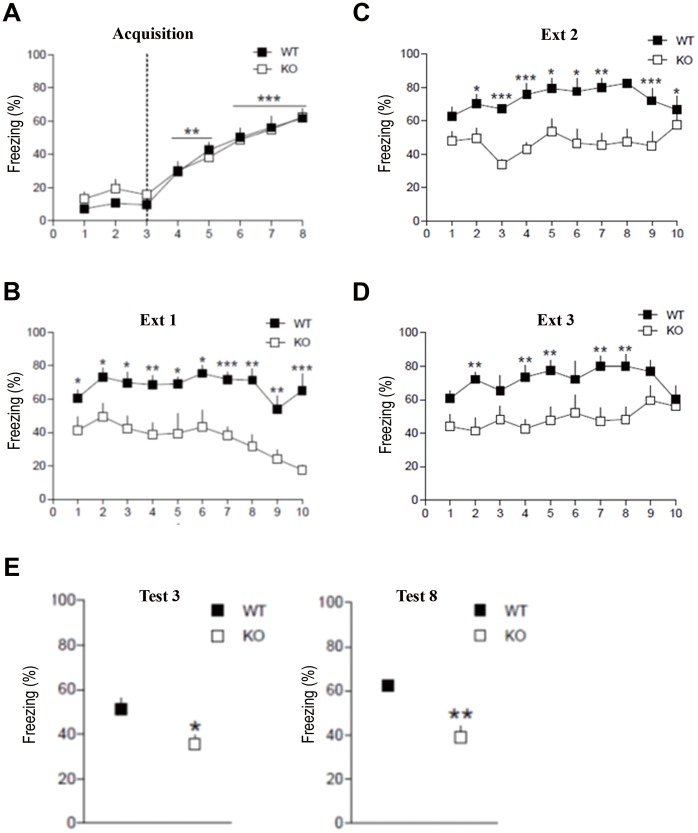
Contextual fear conditioning and extinction in FMR1−/− mice and WT littermates.(A) Acquisition of contextual fear conditioning. Mice were placed in a context for 3 min and received a foot shock every 60 sec for 5 times. Mice significantly increase freezing responses when compared to baseline (BL) measures before US presentation **p<0.01; ***p<0.001 vs. baseline (pairwise comparison test). (B) Extinction training. Mice underwent 3 extinction sessions with and interval of 30 min on day 2. *p<0.05; **p<0.01; ***p<0.001 (genotype effect). (C) Retention test. Freezing behavior was measured on day 3 and day 8 to evaluate long-term extinction memory *p<0.05; **p<0.01 (genotype effect). Data are expressed as mean ±s.e.m.